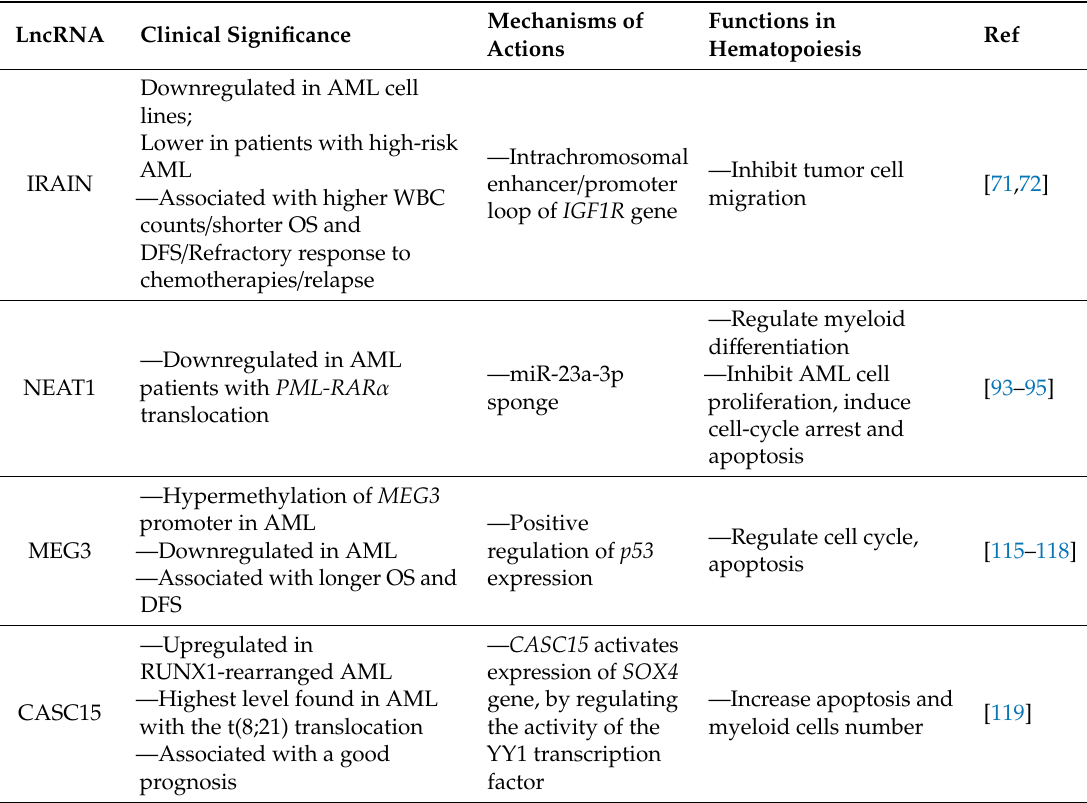
Table 2. Tumor Suppressor lncRNAs in Acute Myeloid